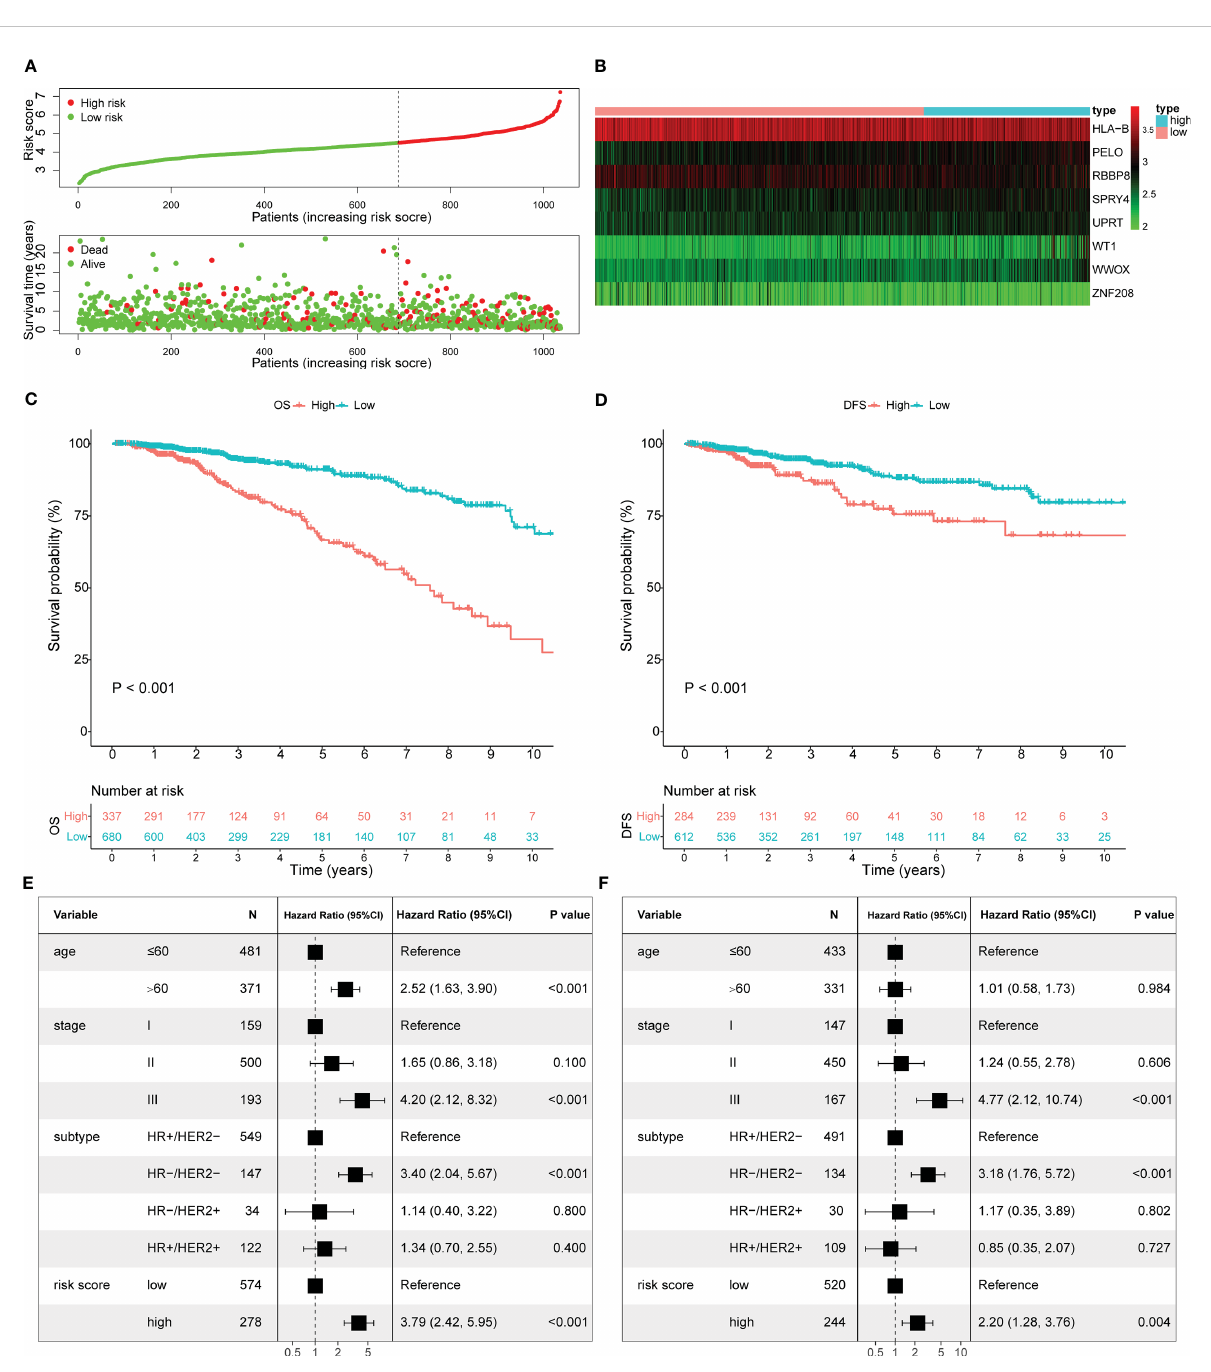
FIGURE 3 Estimate the prognostic value of ovarian ageing-related gene (OARG) signature model in TCGA cohort. (A) The distribution of risk scores in the TCGA and patient distribution in the high- and low-risk group according to overall survival (OS) status. (B) The heatmap showing expression pro fi les of the 8 OARGs. (C) Kaplan-Meier curves for the OS of patients in the high- and low-risk groups. (D) Kaplan-Meier curves for the diseases-free survival (DFS) of patients in the high- and low-risk groups. (E) Multivariate Cox regression analysis of OS. (F) Multivariate Cox regression analysis of